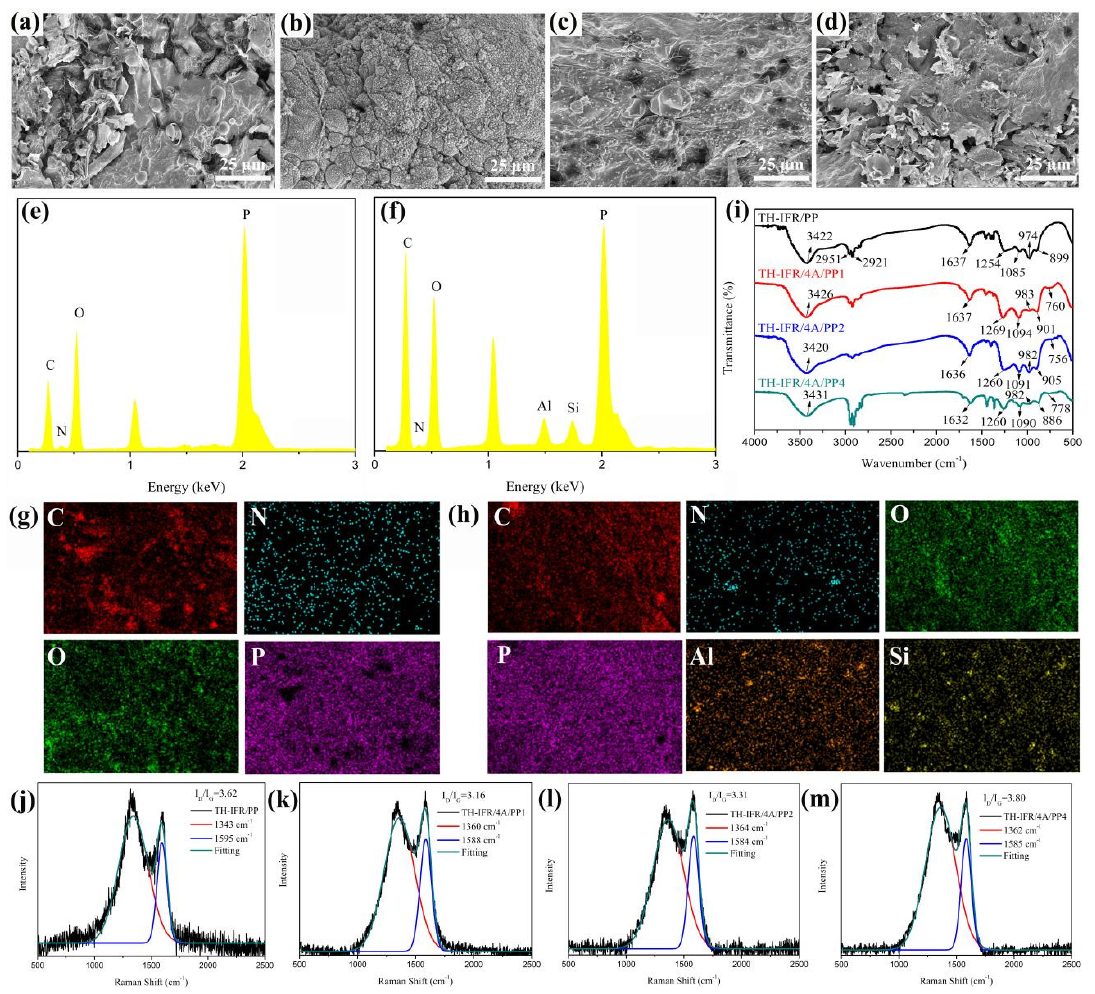
Figure 8. The FESEM images of carbon residue for TH-IFR/PP ( a ), TH-IFR/4A/PP1 ( b ), TH-IFR/4A/PP2 ( c ) and TH-IFR/4A/PP4 ( d ); EDS spectra of carbon residue for TH-IFR/PP ( e ) and TH-